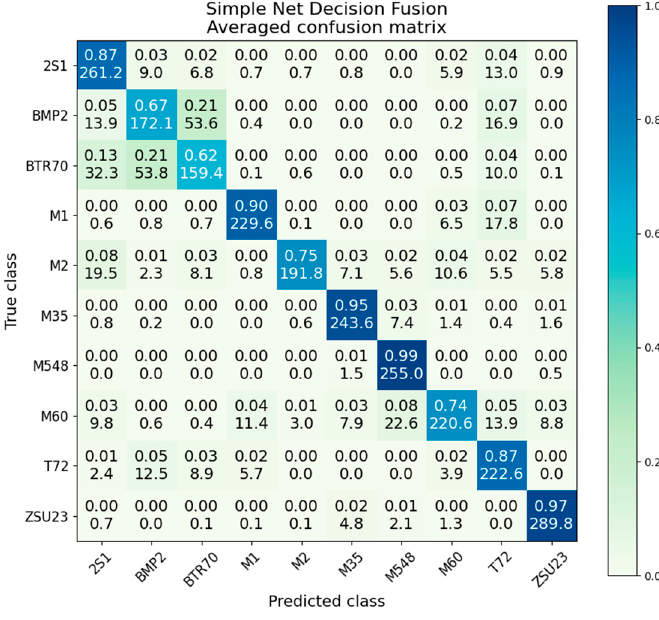
Figure 16. Averaged confusion matrix for simple net decision fusion.